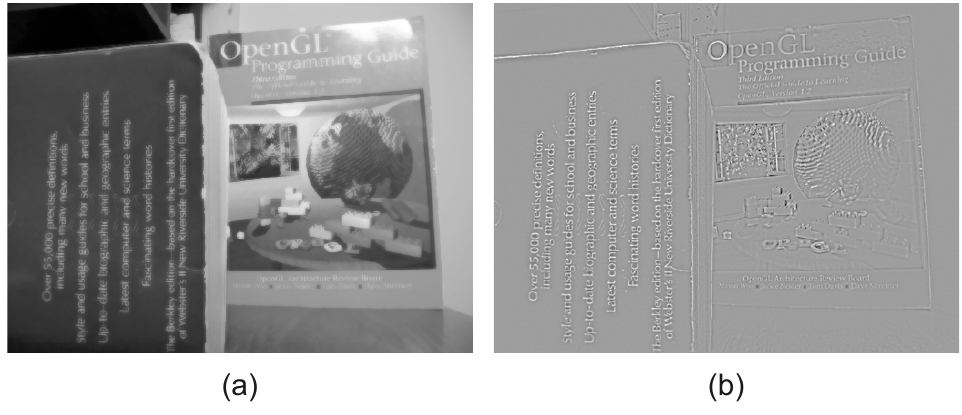
Figure 7. ( a ) Fused low frequency, ( b ) Fused high frequency.